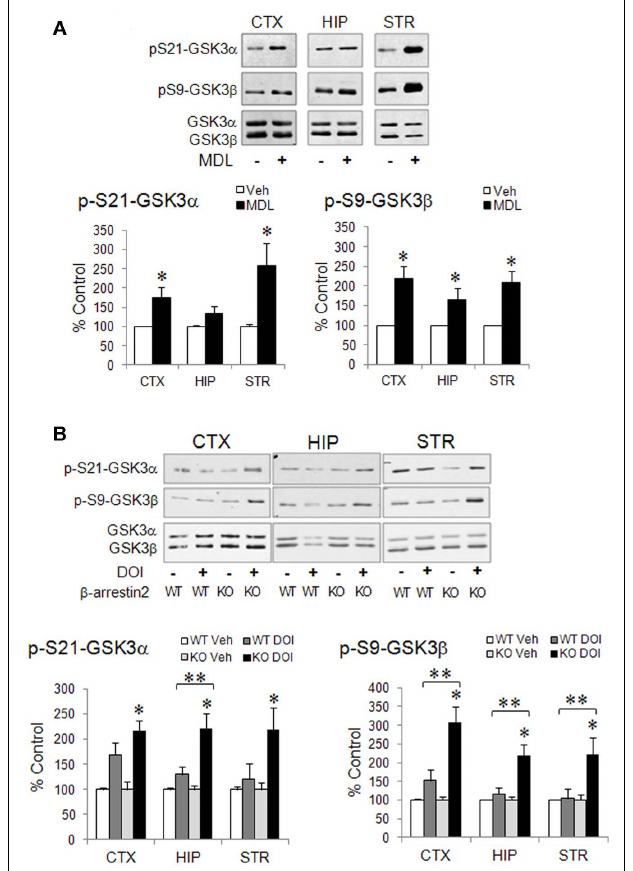
FIGURE 3 | Regulation of phospho-Ser-GSK3 by 5-HT2A receptor ligands in mouse brain. (A) Wild type mice were treated with saline (Veh) or the 5-HT2A receptor antagonist MDL11939 (MDL, 4mg/kg, i.p., 1h). Immunoblots of phospho-Ser21-GSK3 α , phospho-Ser9-GSK3 β , total GSK3 α , and total GSK3 β in the cerebral cortex, hippocampus, and striatum are quantified by densitometry. Mean ± SEM, * p < 0.05 when values are compared to saline treatment in Student’s t -test, n = 4–13. (B) Wild type (WT) and β -arrestin2-knockout (KO) mice were treated with saline (Veh) or DOI (20mg/kg, i.p.) for 1h. Immunoblots of phospho-Ser21-GSK3 α , phospho-Ser9-GSK3 β , total GSK3 α , and total GSK3 β in the cerebral cortex, hippocampus, and striatum are quantified by densitometry. Mean ± SEM, * p < 0.05 between saline and DOI treatment within the same genotype, Student’s t -test; ** p < 0.05, two-way ANOVA followed by Holm–Sidak comparison, n =